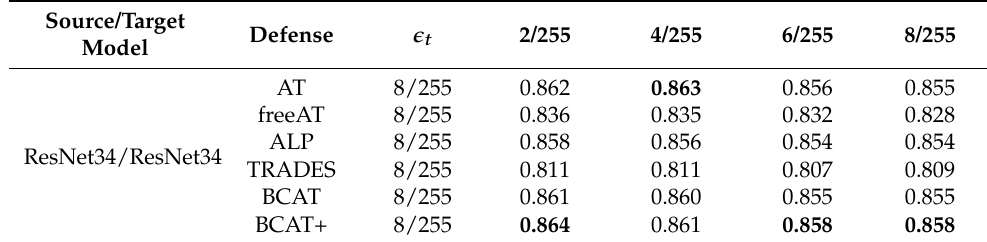
Table 4. Comparing the black-box adversarial robustness generalization accuracy of different defense methods on CIFAR-10.